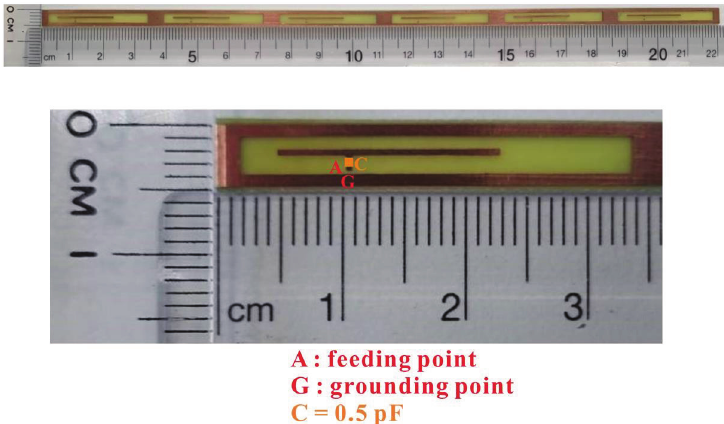
Figure 4. Single closed-slot antenna detail structure.